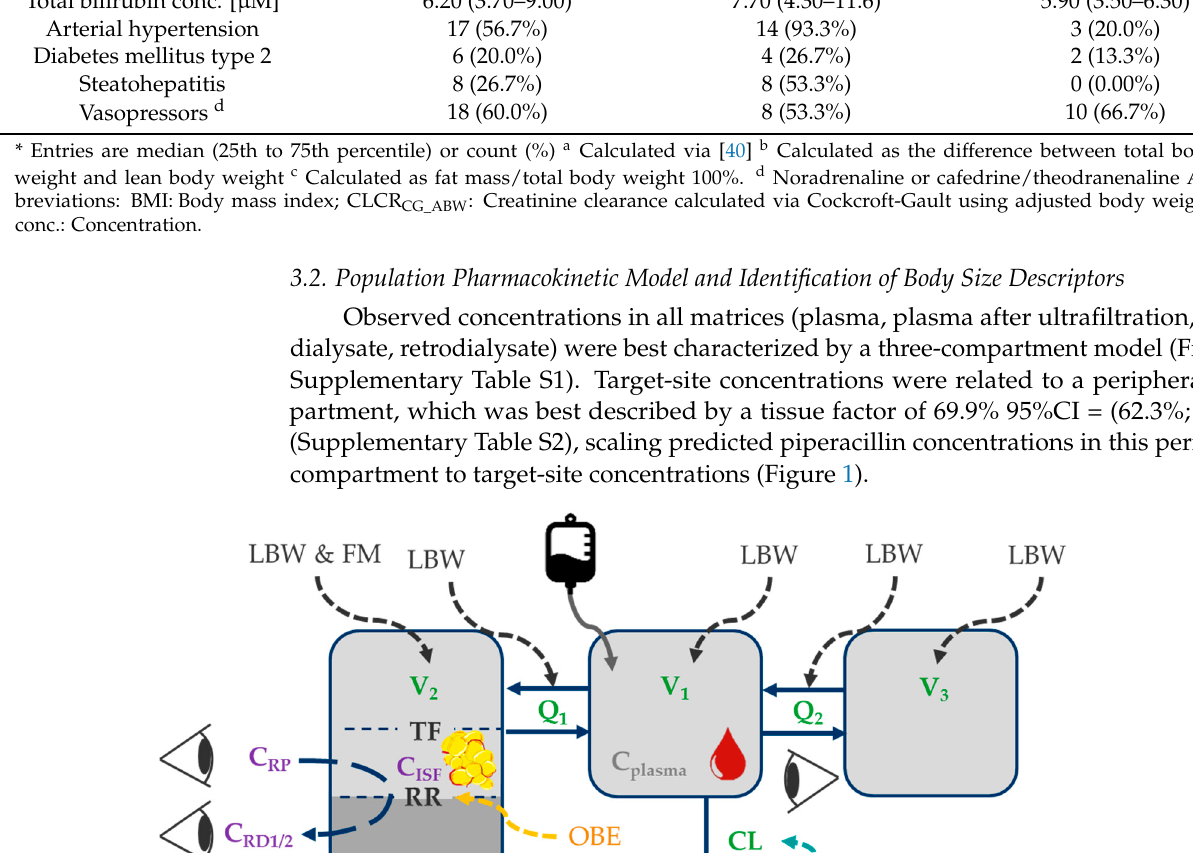
Table 3. Patient-specific characteristics of obese and nonobese patients.